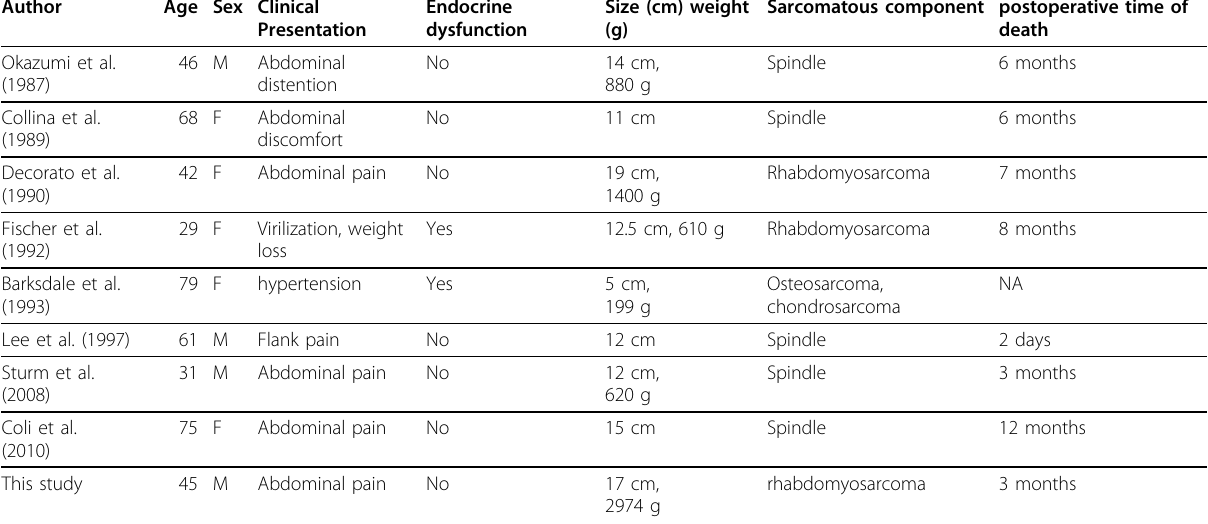
Table 2 Clinicopathologic features of adrenocortical sarcomatoid